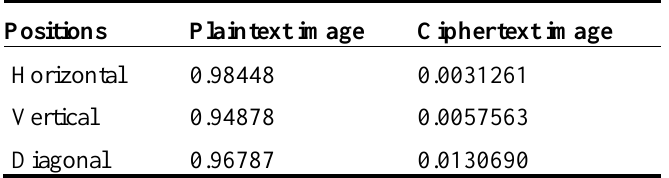
Table 6. The correlation coefficients of the adjacent